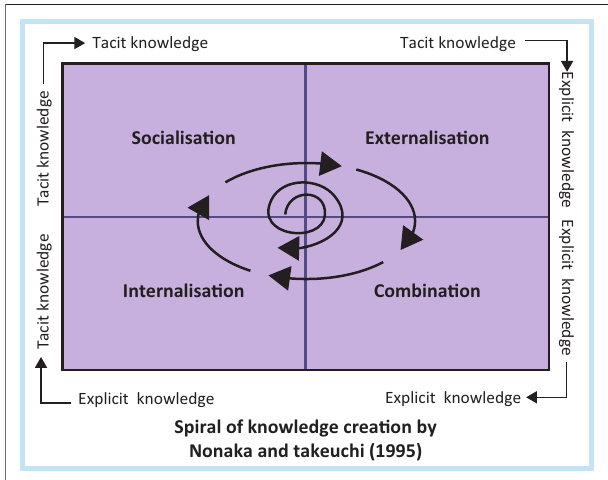
FIGURE 1: Socialisation, externalisation, combination and internalisation